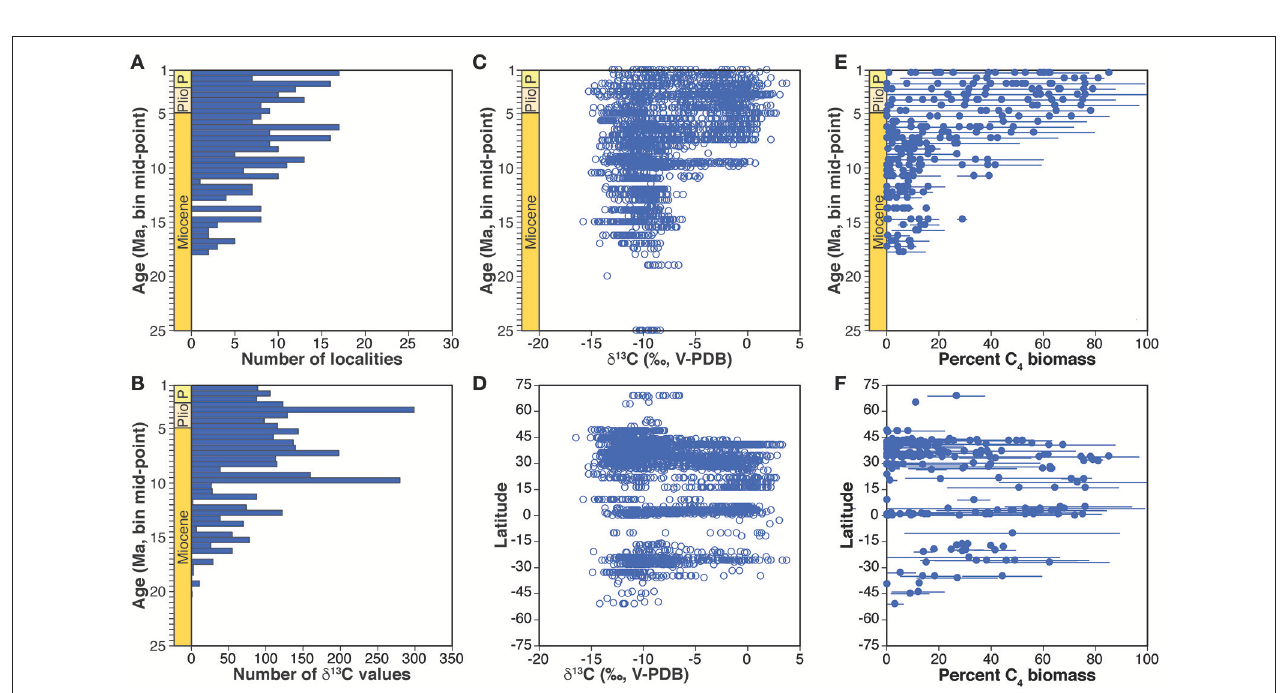
FIGURE 3 | Summary of the compilation of biomineral δ 13 C values. Number of localities (A) and δ 13 C values (B) in each 0.5 Myr bin. All δ 13 C values by mid-point of 0.5 Myr age bin (C) and by latitude of sample site (D) . Mean and standard deviation of estimated percent C 4 biomass for each locality by midpoint of 0.5 Myr age bin (E) and by latitude of site (F)